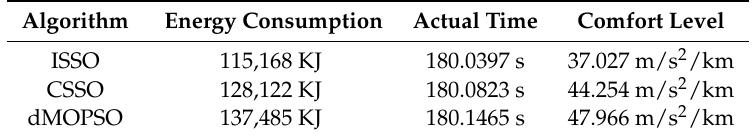
Table 13. The HILS tracking control results of different algorithms for rail transit line No.12 in Dalian